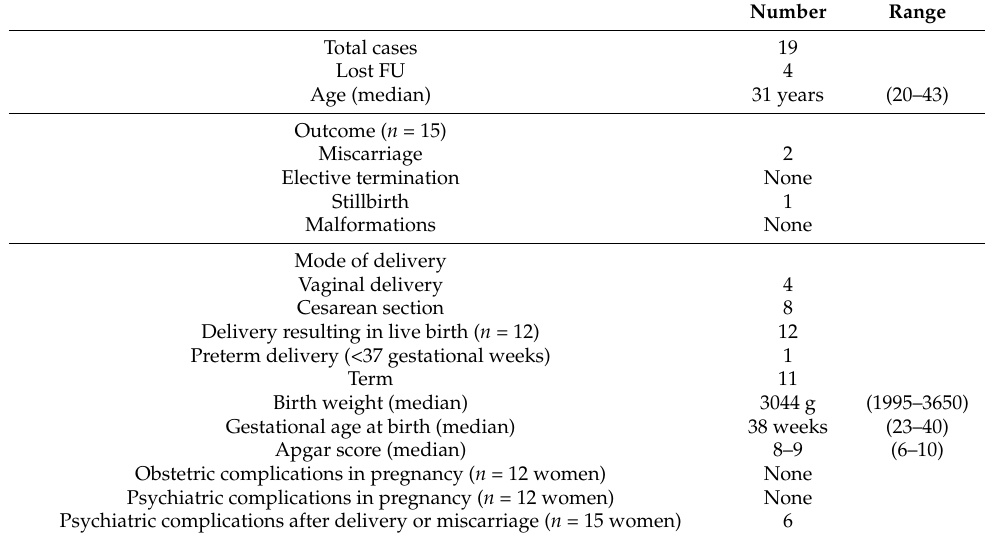
Table 2. Pregnancy outcome, infant and maternal